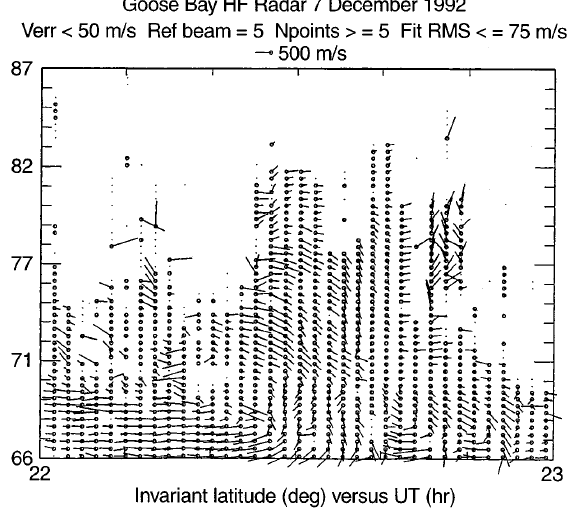
Fig. 9. Derived flow vectors for beam 5 of the Goose Bay radar plotted as a function of UT and invariant latitude for